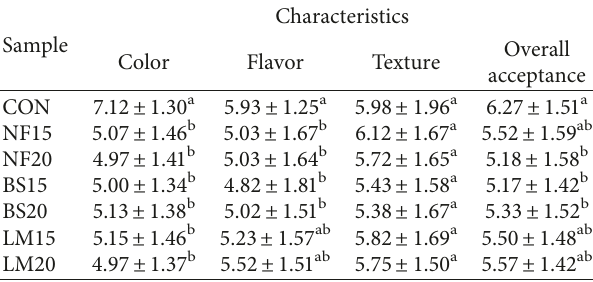
Table 4: Sensory evaluation scores of rice and potato garaetteoks